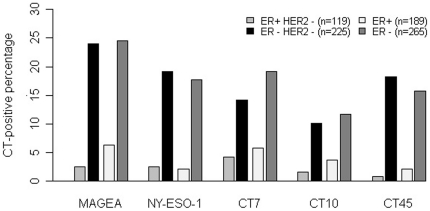
Distribution of CT antigen expression percentages in ER-positive and ER-negative breast cancer.Comparisons were carried out for each CT antigen between ER+HER2- and ER-HER2- cases and between all ER+ and ER- cases. Significant differences were found for all comparisons (P<0.005).